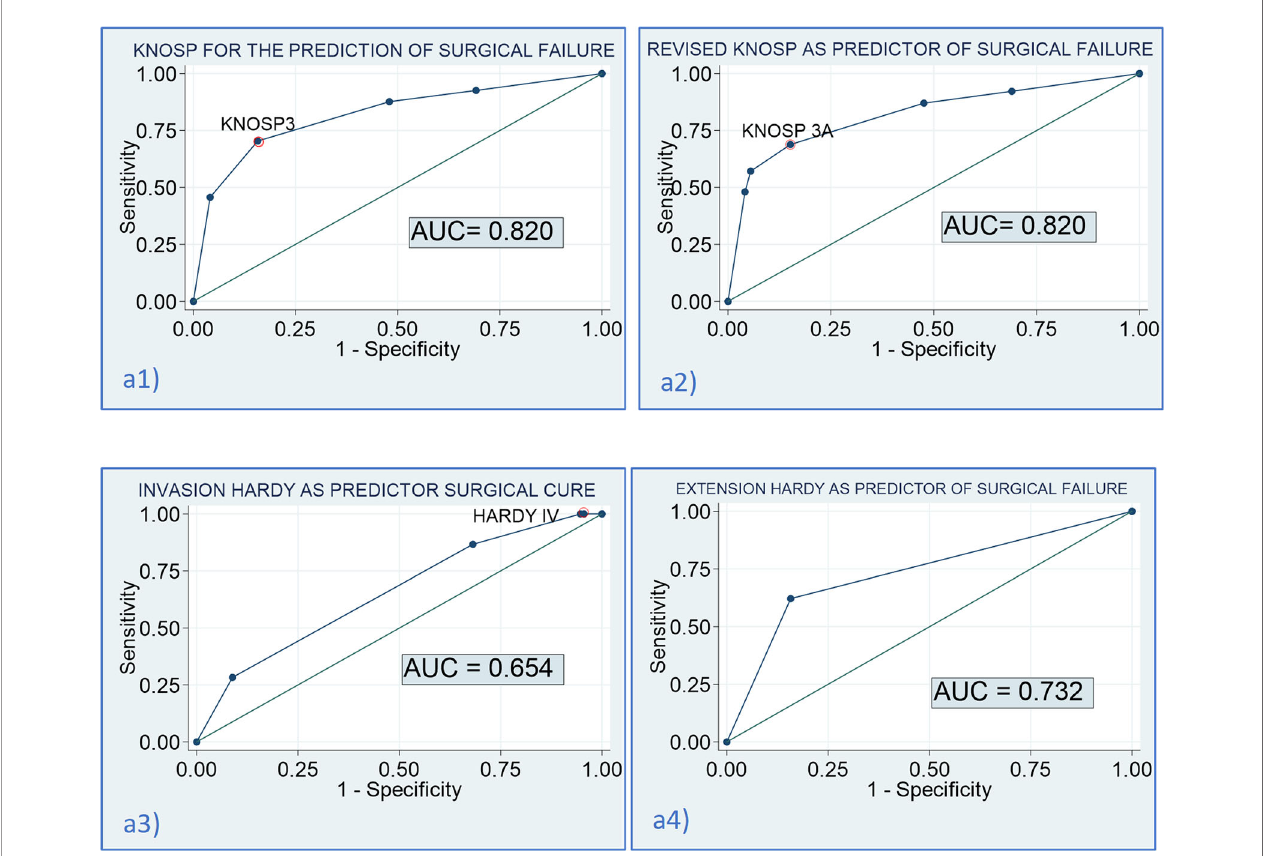
FIGURE 5 | Diagnostic accuracy of the Knosp and Hardy scales for the prediction of surgical cure. (a1) AUC of the Knosp scale for the prediction of surgical failure: 0.820 [0.760 – 0.879]; optimal cutoff for the prediction of failure: Knosp 3 [sensitivity (Se) = 70.4% (59.7 – 79.2), speci fi city (Sp) = 84.2% (77.5 – 89.3); a2] AUC of the revised-Knosp scale for the prediction of surgical failure: 0.820 [0.760 – 0.882]; optimal cutoff for the prediction of failure: Knosp 3A [Se= 68.8% (57.8 – 78.1), Sp = 84.8% (78.1 – 89.8); a3] AUC of the invasion Hardy scale for the prediction of surgical failure: 0.654 [0.580 – 0.728]; optimal cutoff for the prediction of failure: Hardy IV [Se = 86.7% (75.8 – 93.1), Sp = 31.9% (24.0 – 40.9); a4] AUC of the extension Hardy scale (A – D vs. E) for the prediction of surgical failure: 0.732 [0.672 – 0.793]; optimal cutoff for the prediction of failure: Hardy stage E [Se = 62.2% (51.4 – 71.9), Sp = 84.2% (77.5 –